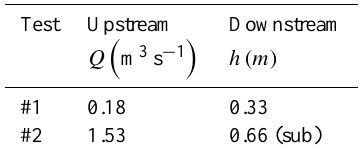
Figure 6. Wiggert experimental setup.